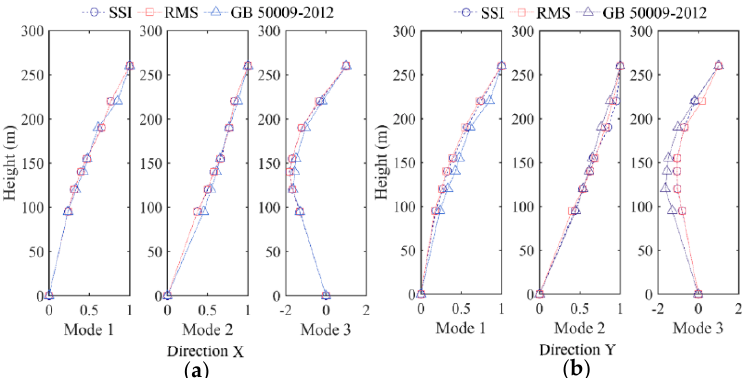
Figure 15. Mode shapes identified via SSI and root-mean-square (RMS) methods against code predictions for the first two swaying modes (i.e., Mode 1 and Mode 3) and the first torsional mode (Mode 2). ( a ) Dir-X; ( b ) Dir-Y.